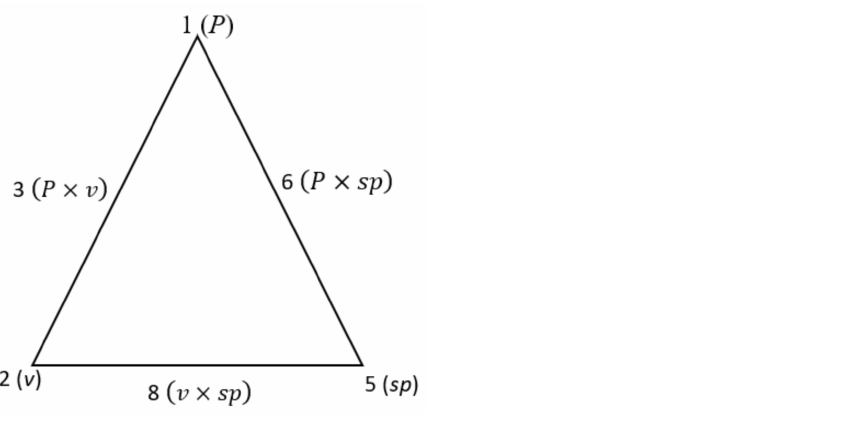
Figure 3. Linear graph for assigning factors and interaction in L 27